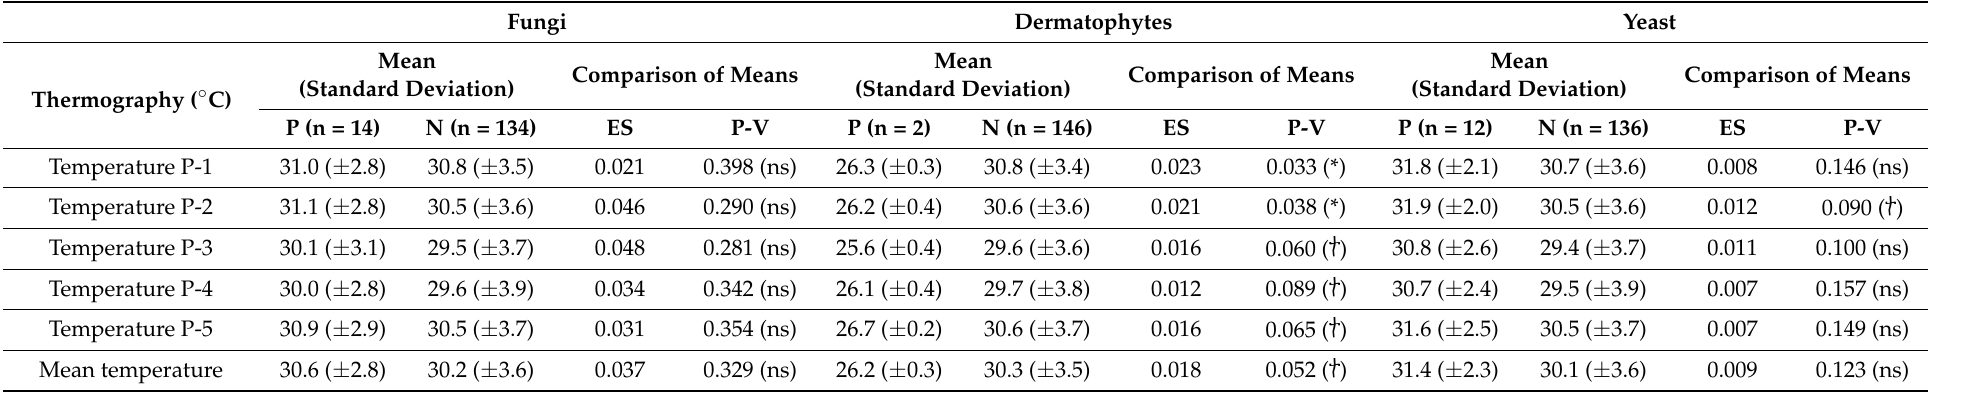
Table 4. Relation between results of thermography variables and prevalence of infection in women: fungi, dermatophytes and yeast. Fungi Yeast